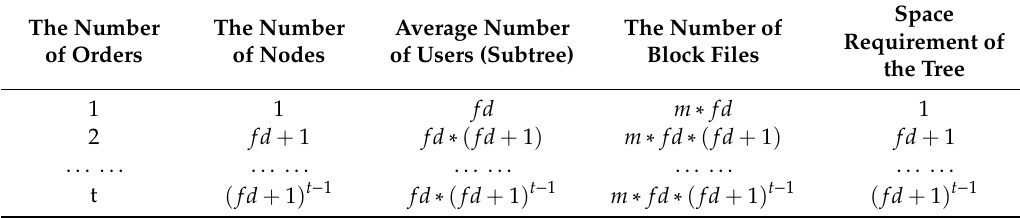
Figure 12. Example block retrieval diagram for “User Block Set”. Table 1. B + -tree series, number of Block files and space